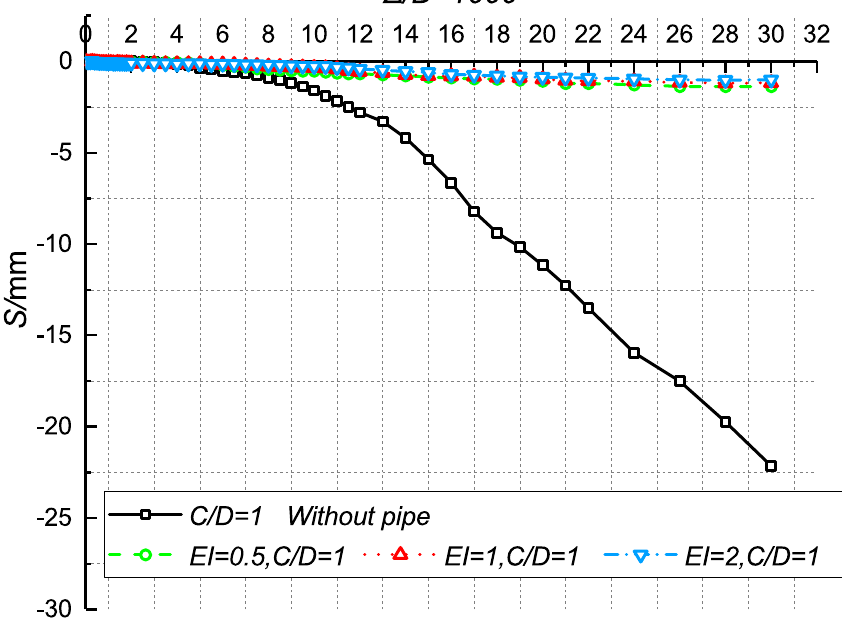
Figure 9. Variation in the ground settlement with excavation face displacement ( ∆ / D ×